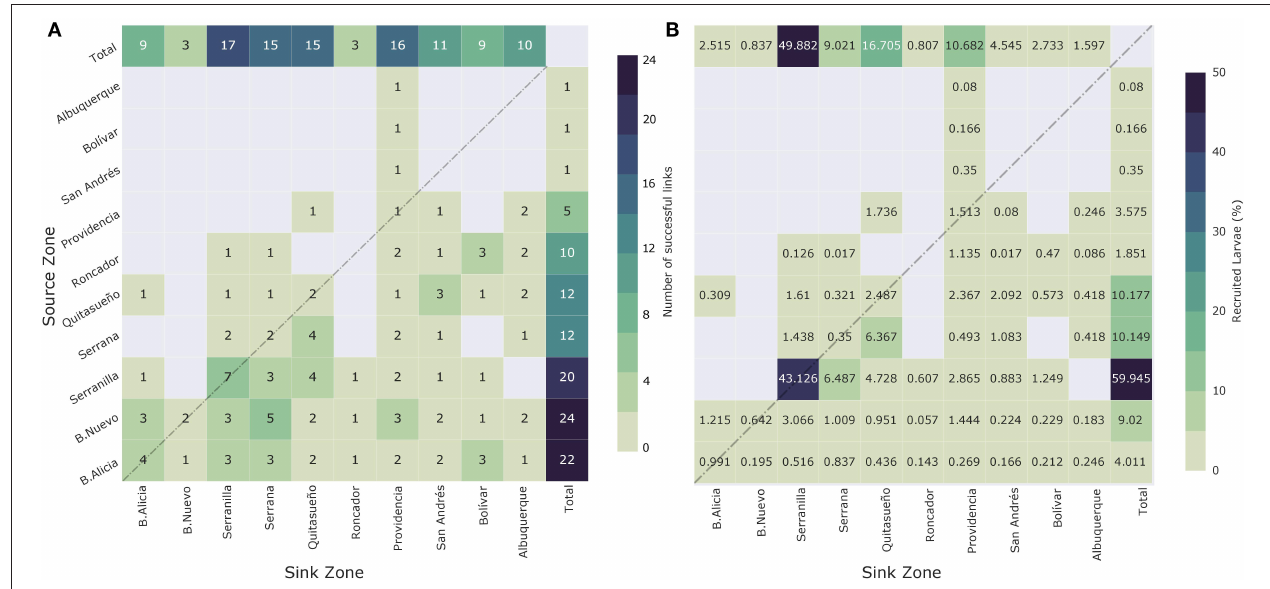
FIGURE 8 | (A) Connectivity summary matrix for all spawning events. Row sums show the number of times that reef i acts as a source for all the reefs. Column sums indicate the number of times that reef j acts as a sink for all reefs (including self-recruitment). (B) Contribution of each i - j connection with respect to the overall recruitment across SFBR for all spawning events. Row sums indicate the percentage contribution of each source i to the total amount of recruited larvae. Column sums indicate the proportion of larvae received by the sink j